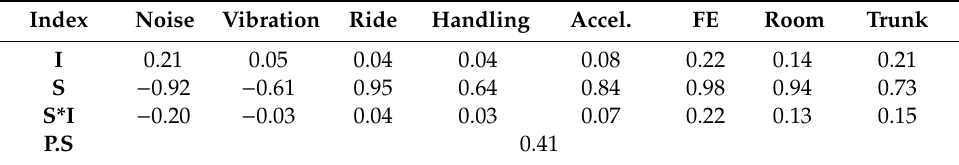
Figure 11. Satisfaction for each performance aspect of “Product D”, released in the second half of 2019. Table 3. I, S, and SI of each performance aspect for “Product D”.